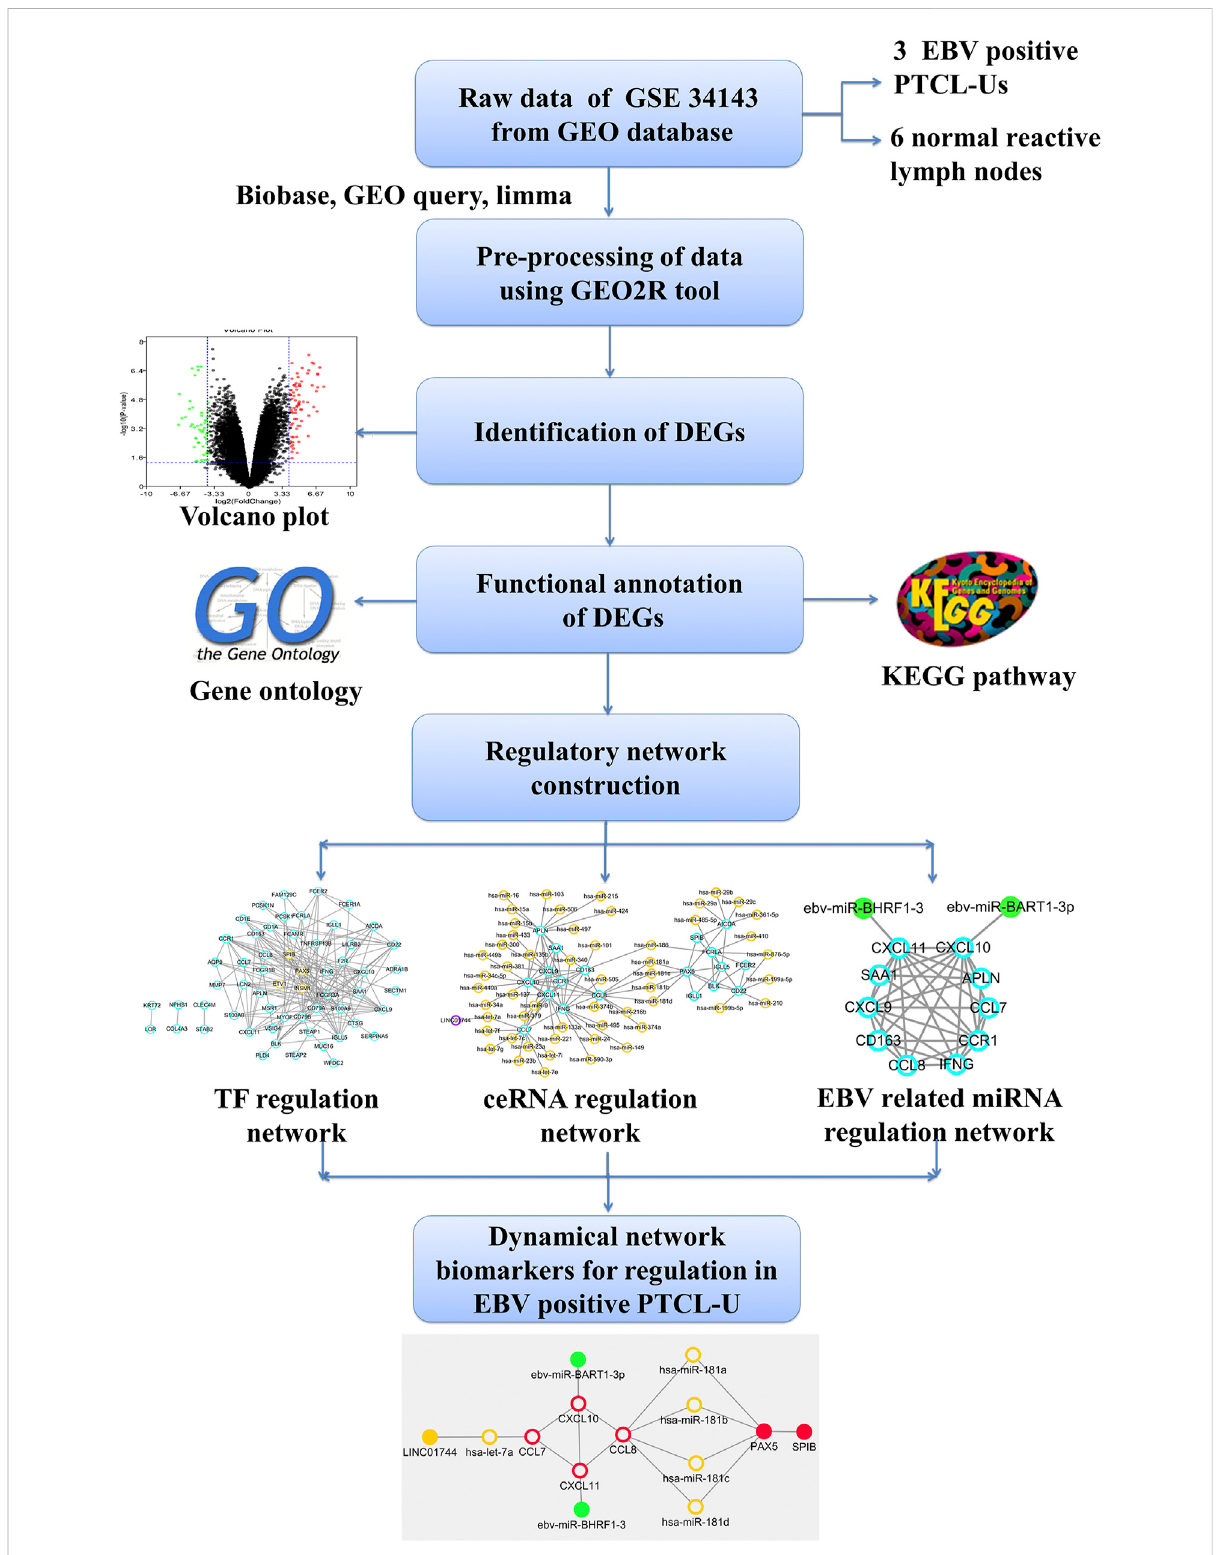
FIGURE 1 Outline of the work fl ow and expression data analysis in the present study using bioinformatic